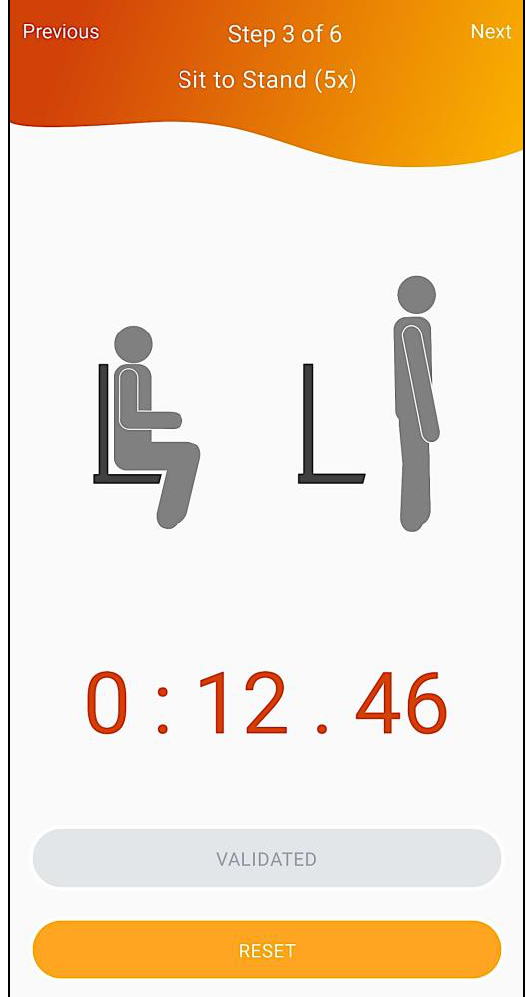
Figure 5. Five-repetition sit-to-stand test.